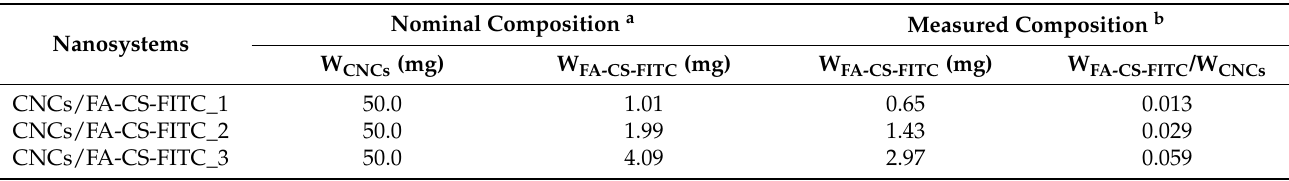
Table 1. Composition of the prepared CNCs/FA-CS-FITC